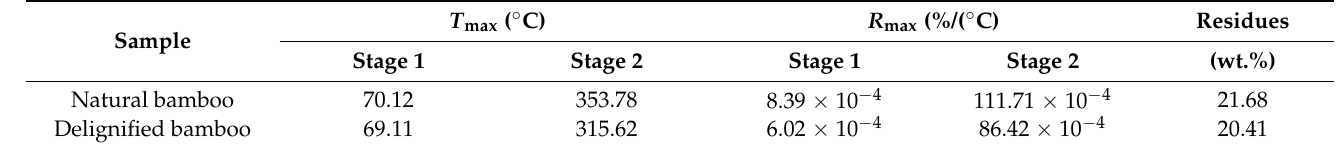
Figure 5. ( a ) Thermogravimetric analysis (TGA) and ( b ) derivative thermogravimetry (DTG) curves of NB and DB. Table 4. TGA data for NB and